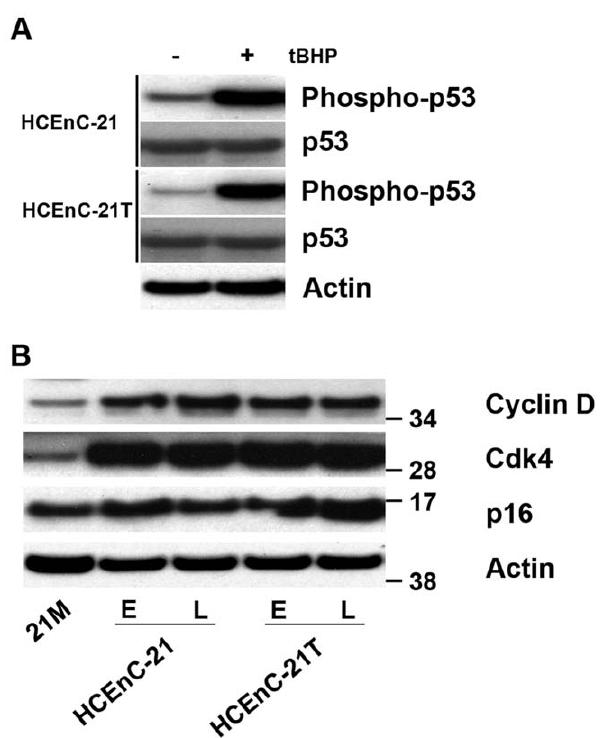
Figure 3. Synthesis of cyclin D, CDK4, p16 INK4 and p53 in HCEnC-21 and HCEnC-21T. (A) Analysis of p53 functionality. Oxidative stress was induced in confluent monolayers of HCEnC-21 and HCEnC-21T cells using 50 m M tert -Butyl-hydroperoxide for 1 hr. Cell extracts were then separated by SDS-PAGE and immunoblotted with antibodies against p53, phospho-p53 (serine-15), and b -actin. P53 was detected in extracts of both HCEnC-21 and HCEnC-21T and levels of phospho-p53 (activated p53) were increased upon induction of oxidative stress. E: earlier passages , 25. L: later passages . 45. (B) Synthesis of G1 phase regulatory proteins. Cell extracts were run on SDS-polyacrylamide gels and immunoblotted with antibodies against cyclin D, CDK4, p16 INK4 and b -actin. No changes in p16 INK4 protein levels were detected. Cyclin D and CDK4 levels were increased in both, HCEnC-21 and HCEnC-21T compared to